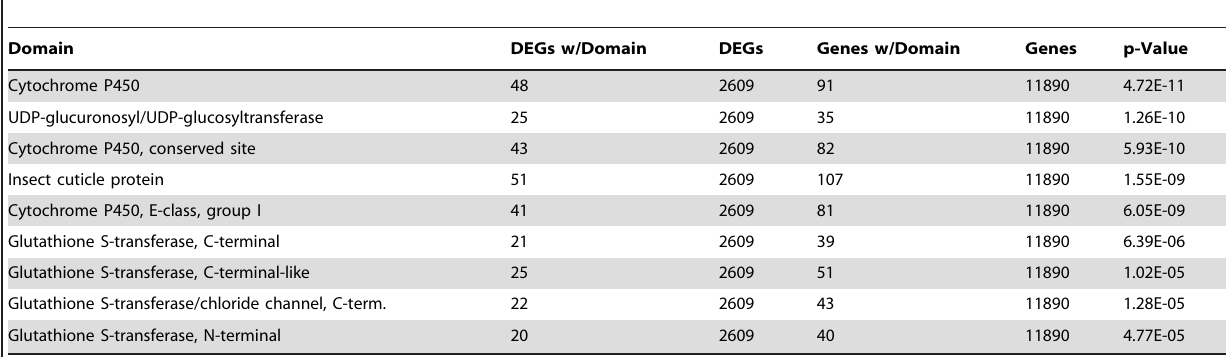
Table 3. Domain enrichment analysis for Ama-KTT/M/2 versus Canton-S on no toxin (group 2 versus 1).